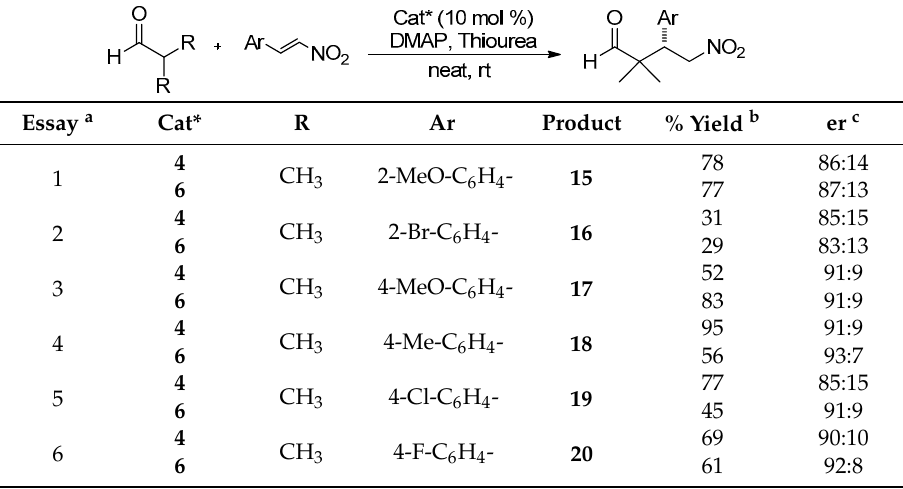
Table 8. Michael addition reaction of aldehydes to different substrates.